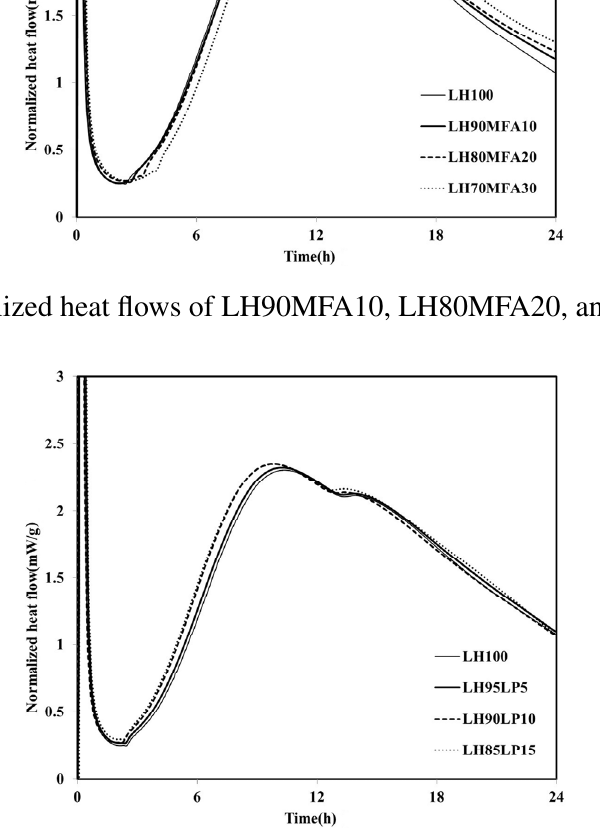
Figure 5. Normalized heat flows of LH95LP5, LH90LP10, and LH85LP15.